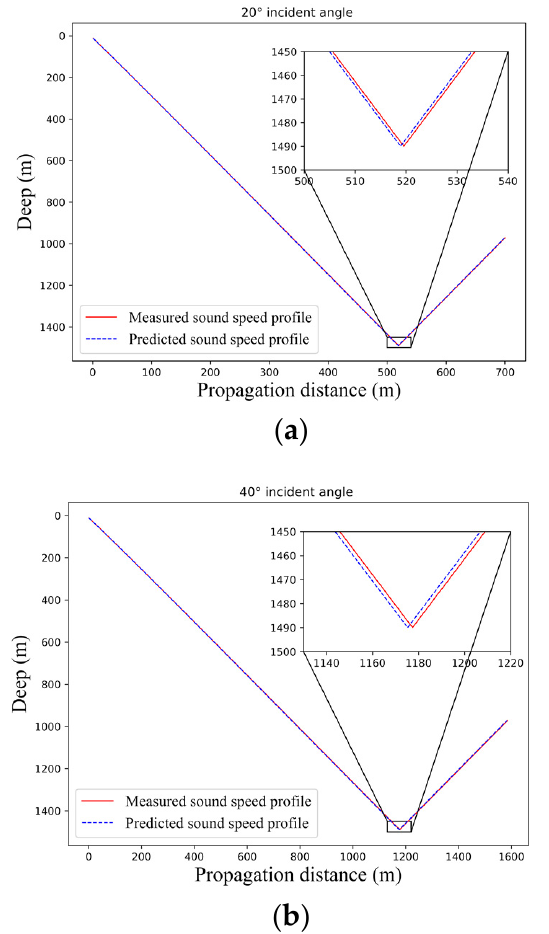
Figure 16. Horizontal errors of the sound ray trace at different incident angles: (a) 20° incident angle, (b) 40° incident angle.